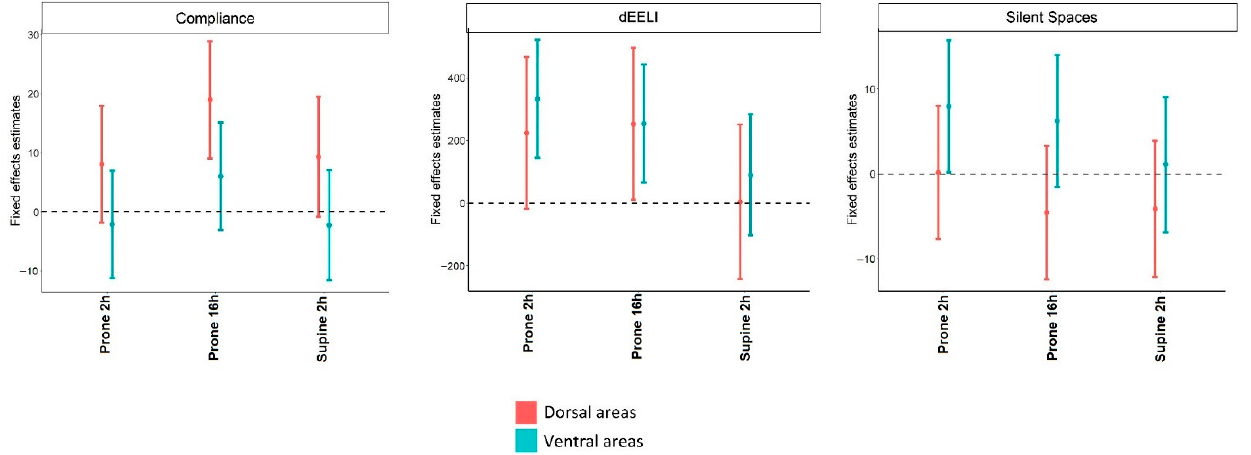
Figure 3. Mixed effect models with a random intercept and only fixed effects using as fixed variable, the examination time, and dependent variables, local compliance, changes in end-expiratory lung impedance, and silent spaces. Values before PP were considered reference values. The regression coefficients and 95% confidence intervals indicate the probability of each variable to be higher or lower compared to the reference value at each time point.